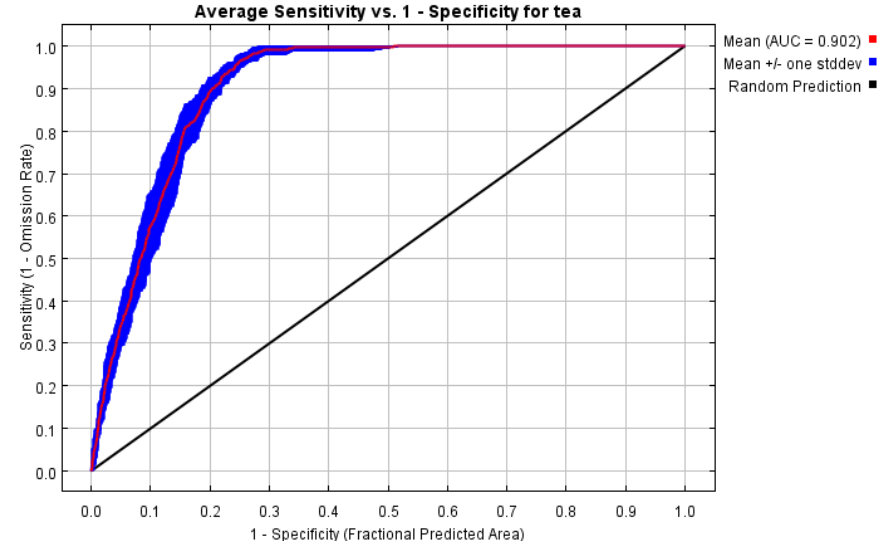
Figure 2. ROC curve and AUC value under the current period (10 replicated runs). The current period was from 1970 to 2000.